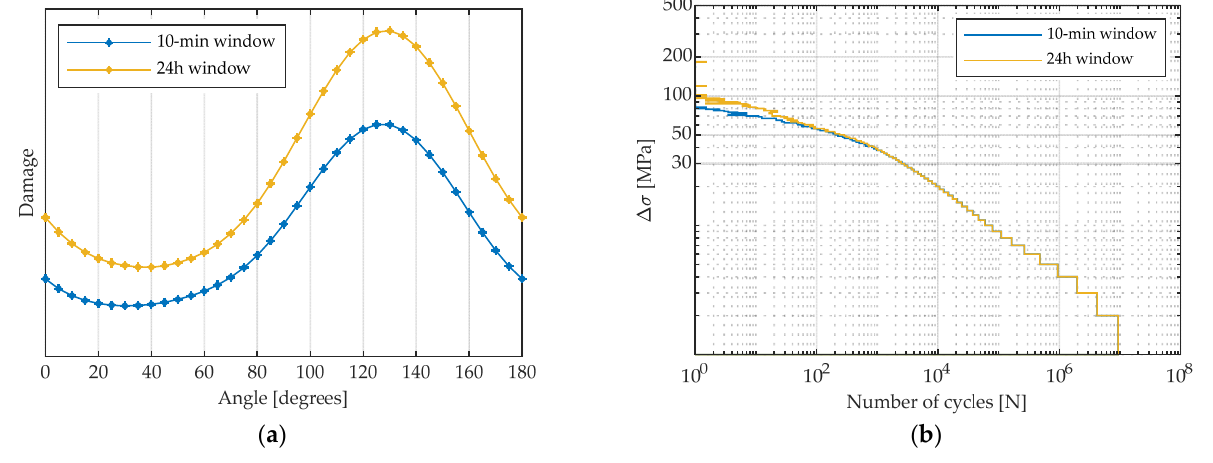
Figure 12. Influence of the window length: ( a ) damage distribution over half of the section (y scale omitted due to confidentiality agreements); and ( b ) histogram of the stress cycles.